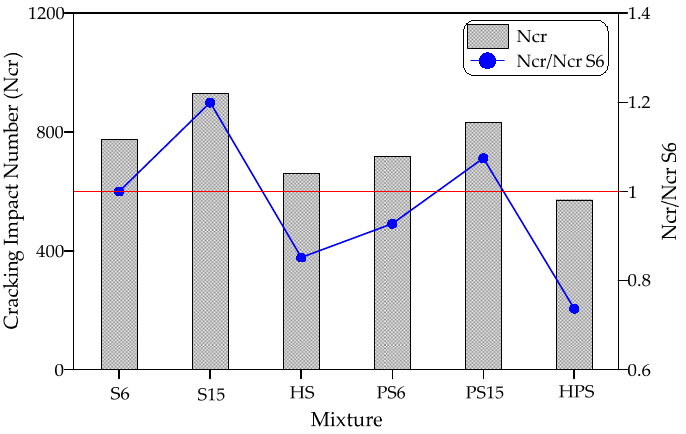
Figure 4. Repeated cracking impact